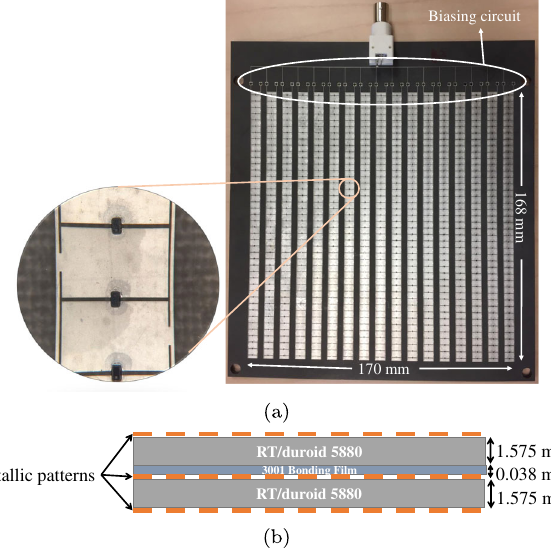
FIG. 10. (a) Cross section of the QWP. (b) Photograph of the fabricated QWP.